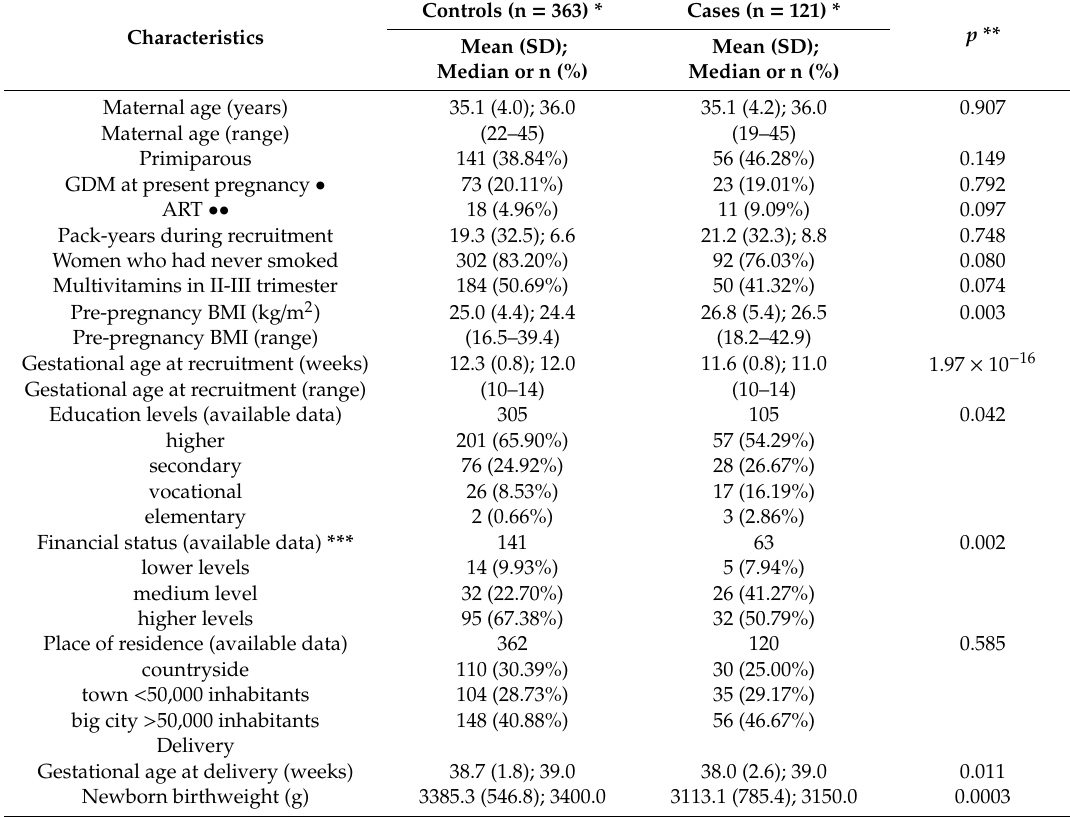
Table 1. The clinical characteristics of the normotensive controls and cases of pregnancy-induced